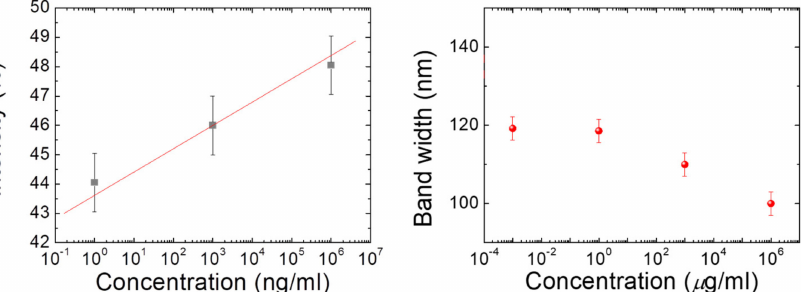
Figure 5. Linear correlation (determination coefficient R2 ≥ 0.93) obtained using 0–1 mg/mL of cTnI.